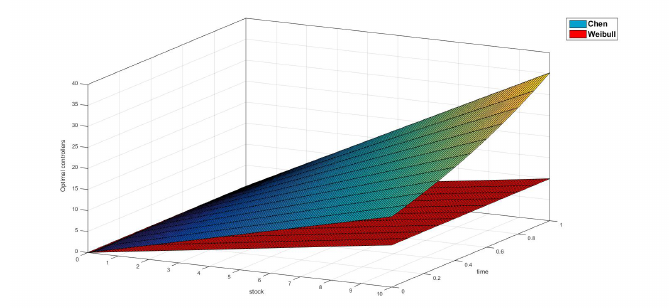
Figure 4. Optimal trajectories for the laws of Weibull (continuous-red) and Chen (dotted-blue) when δ 1 = 1 = δ 2 and λ 1 = 1 = λ 2 .